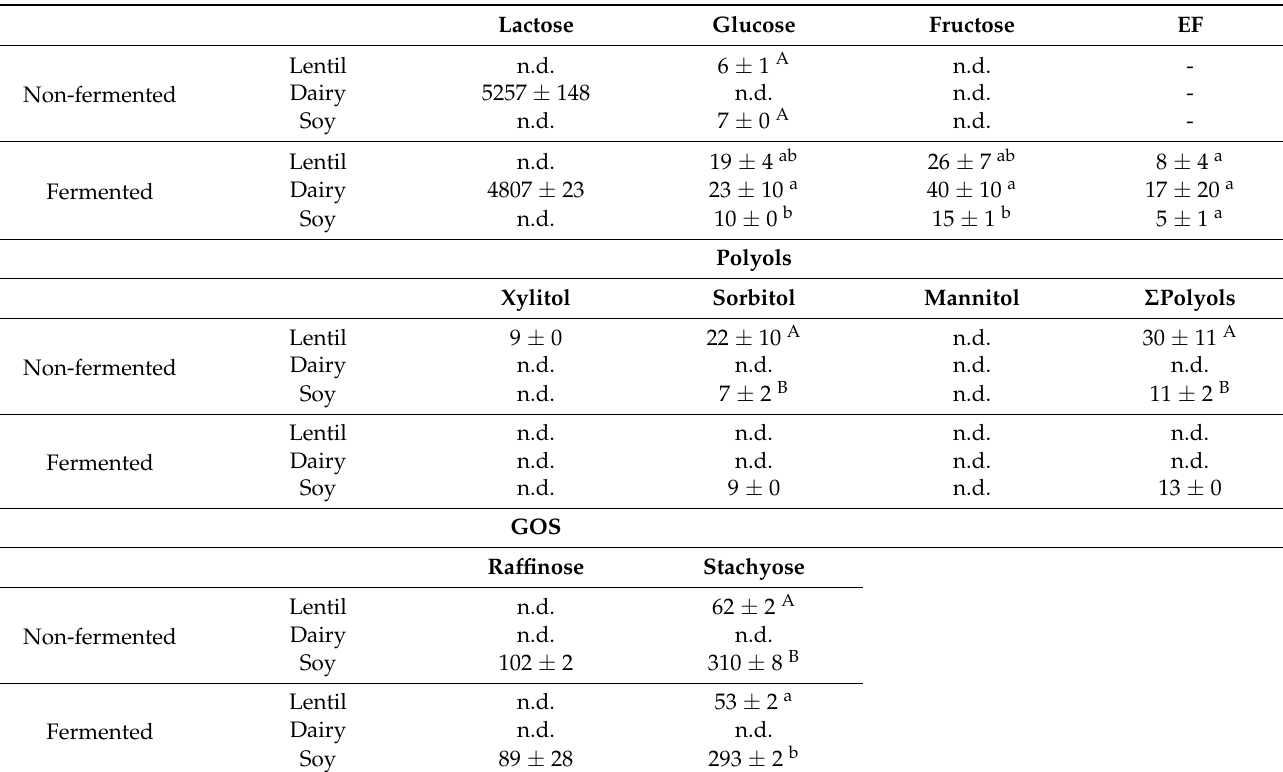
Table 4. FODMAP content as quantified by HPAEC-PAD. All results are given as means in mg/100 g sample ± standard deviations. N.d.: not detected or below 5 mg/100 g. Values within a column of the fermented (lowercase letters) or unfermented product (capital letters) with different superscript letters are significantly different ( p ≤